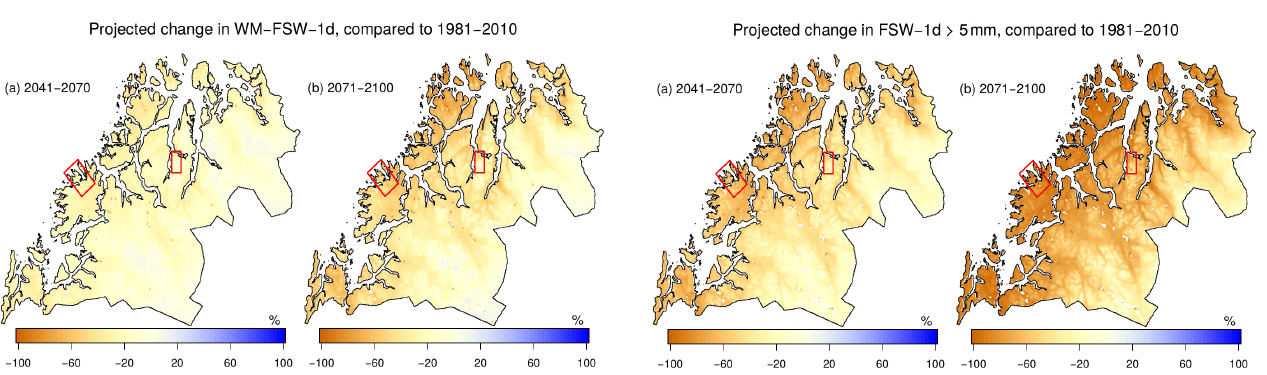
Tromsø municipality, with decreases of around 20 % from the first 30-year period to the last (Fig. 10c). Southern areas inland and coastal areas in the north-east show significant positive trends, with 30 %–50 % more events in the last pe- riod compared to the first.